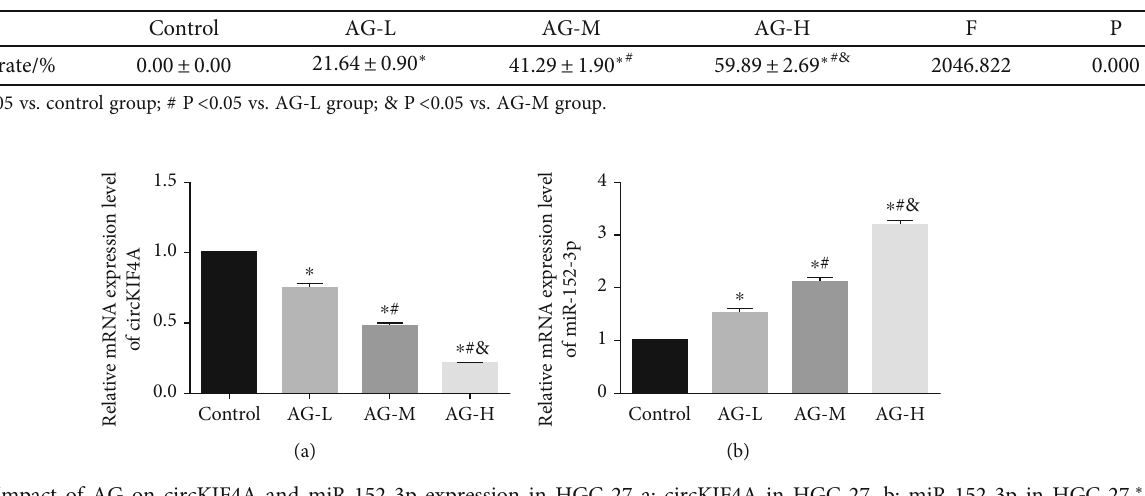
Figure 3: Impact of AG on circKIF4A and miR-152-3p expression in HGC-27 a: circKIF4A in HGC-27. b: miR-152-3p in HGC-27. ∗ P < 0.05 vs. control group; # P < 0.05 vs. AG-L group; & P < 0.05 vs. AG-M group.